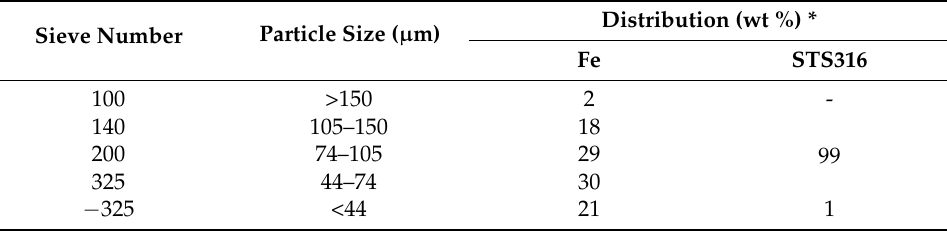
Table 4. Powder distribution measeured by sieve